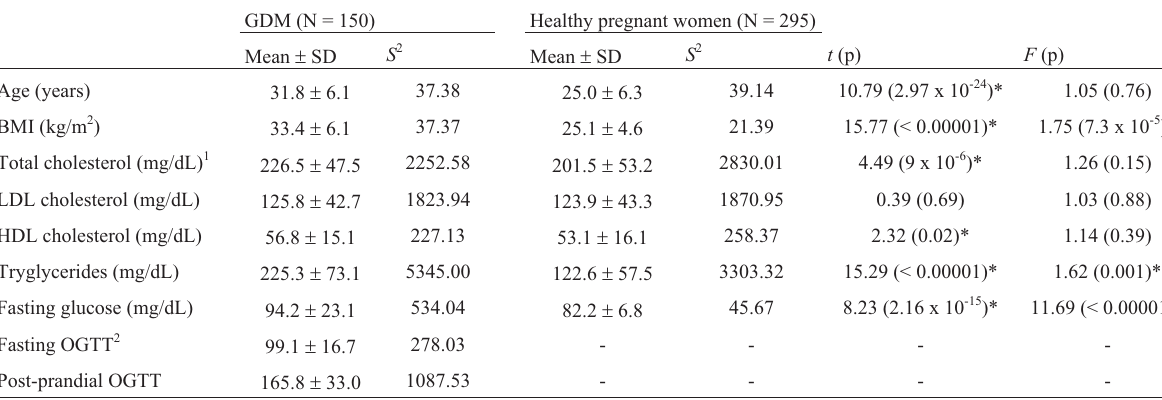
Table 1 - Age, body mass index and clinical features of healthy pregnant women (controls) and pregnant women with gestational diabetes mellitus (GDM).